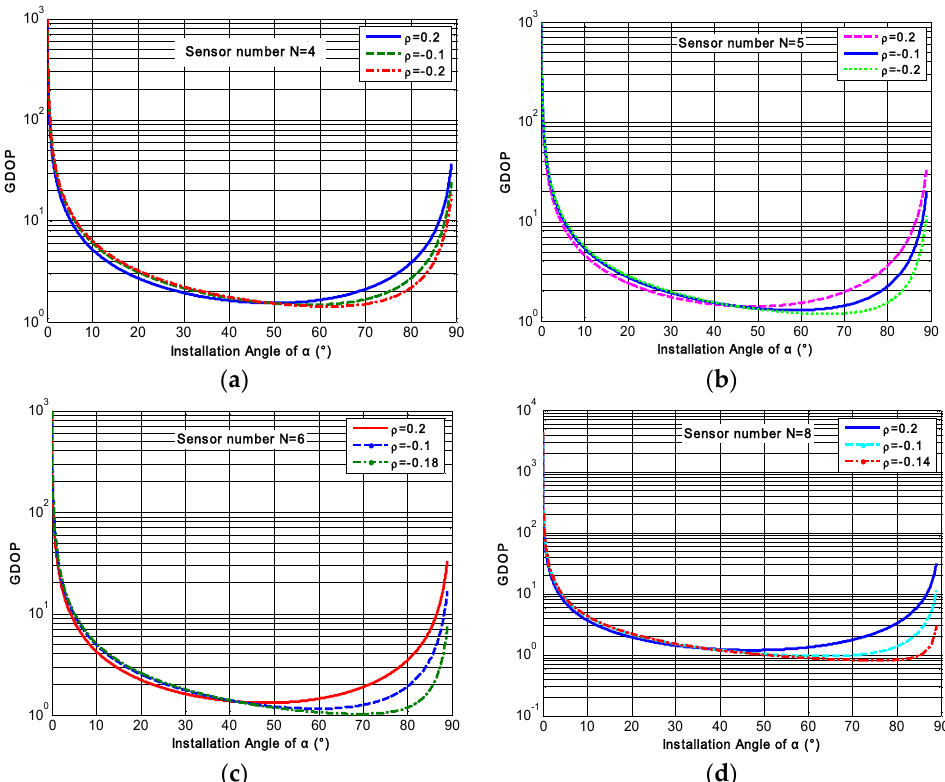
Figure 9. The relationship between GDOP and angle α for different N with various correlation factors: ( a ) N = 4; ( b ) N = 5; ( c ) N = 6; ( d ) N = 8. Table 2. The optimal angle α with different N and ρ . factor ρ n exists in the non-orthogonal array, and its range is [ − 1/( N − 1),1]. The relationship Figure 10.